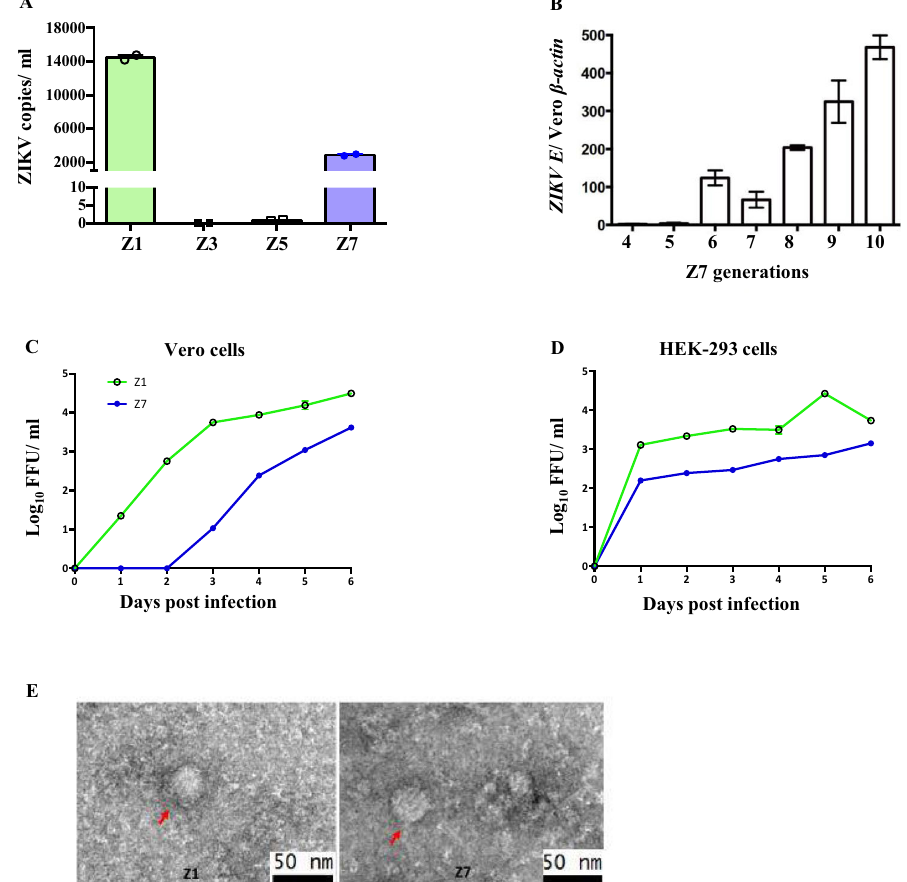
Fig. 2 Characterization of Z7 in vitro. A Quanti fi cation of ZIKV copies of 5 ′ UTR modi fi ed (Z3, Z5, Z7) or unmodi fi ed (Z1) plasmids by qRT- PCR. B Quanti fi cation of ZIKV E in Z7 for several generations (G4 to G10) by qRT-PCR. Data were presented as the ratio of ZIKV E to Vero β -actin . C The in vitro growth curves of Vero cell-generated Z1 and Z7 (G10). Vero cells were infected with 0.1 MOI of Z1 or Z7 (G10), and the virus titers in the supernatants were determined by FFA. D The in vitro growth curves of HEK-293 cell-generated Z1 and Z7 (G11). HEK-293 cells were infected with 0.01 MOI of Z1 or Z7 (G11), and the virus titers in the supernatants were determined by FFA. E TEM images of Z1 and Z7 (G9). A – D Data were presented as mean ±